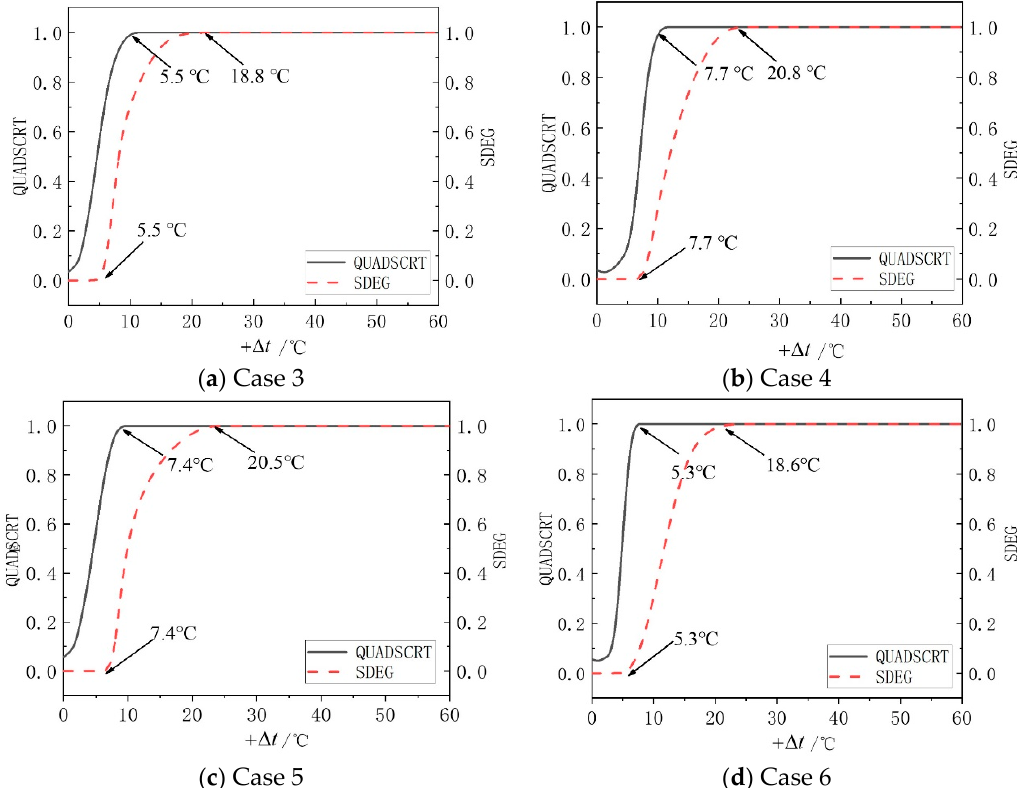
±Δ in cases 3~6. Figure 11. Relationship curves between QUADSCRT / SDEG and ± ∆ t in cases